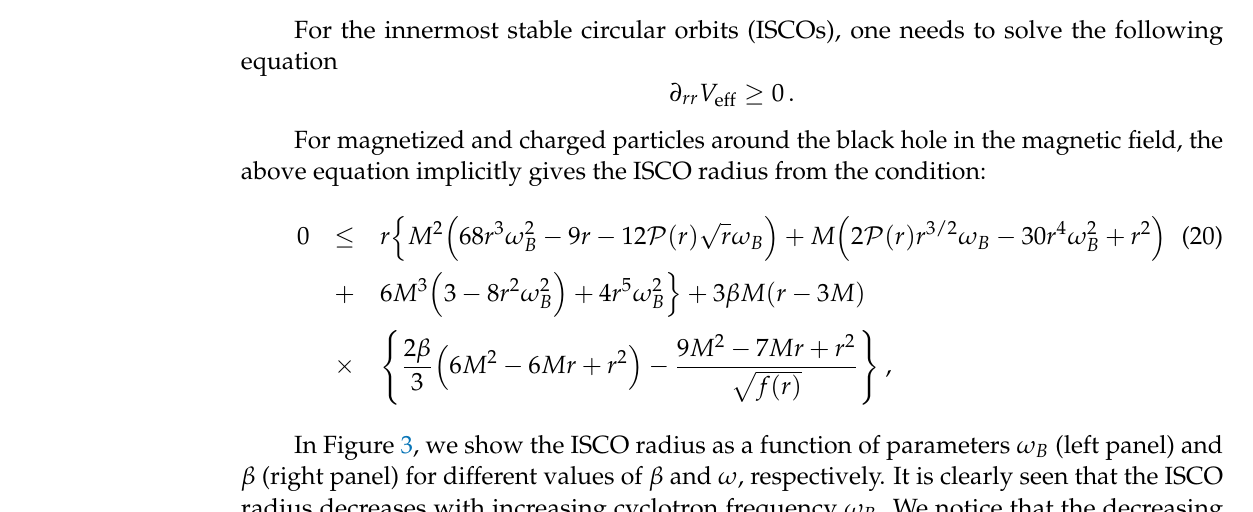
Figure 2. Radial profiles of the specific energy ( left panel ) and angular momentum ( right panel ) for magnetized and charged particles at the circular orbits.